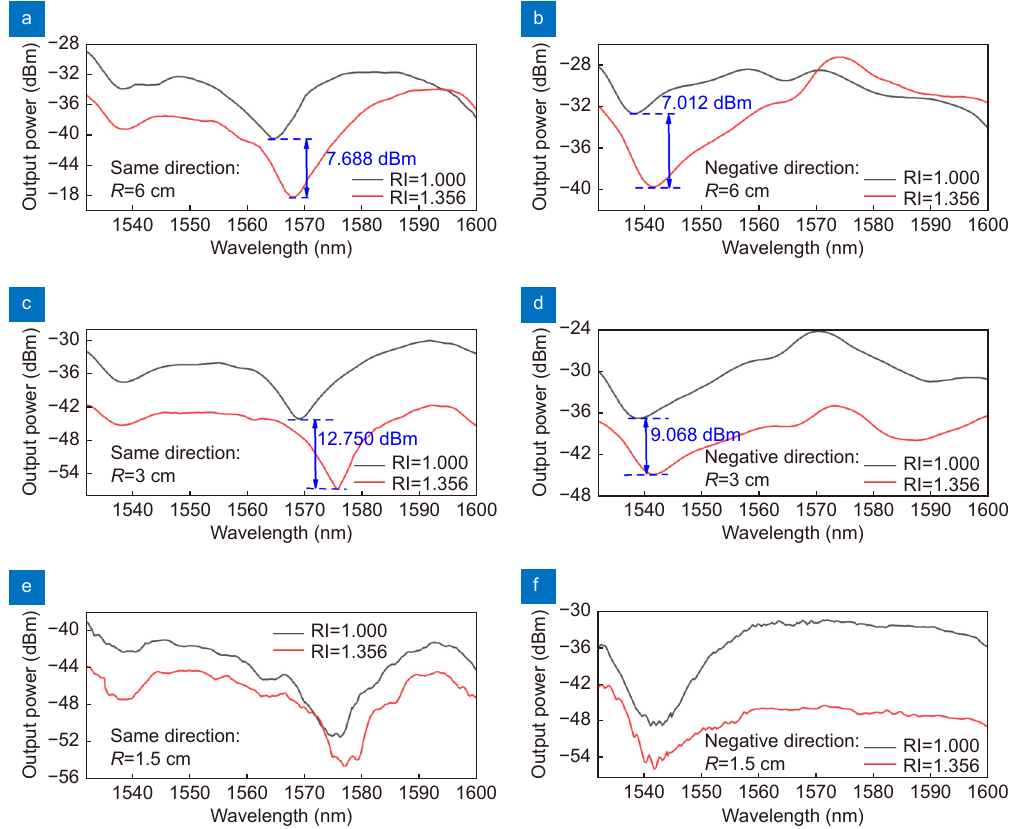
Fig. 10 | Transmission spectra of different macro